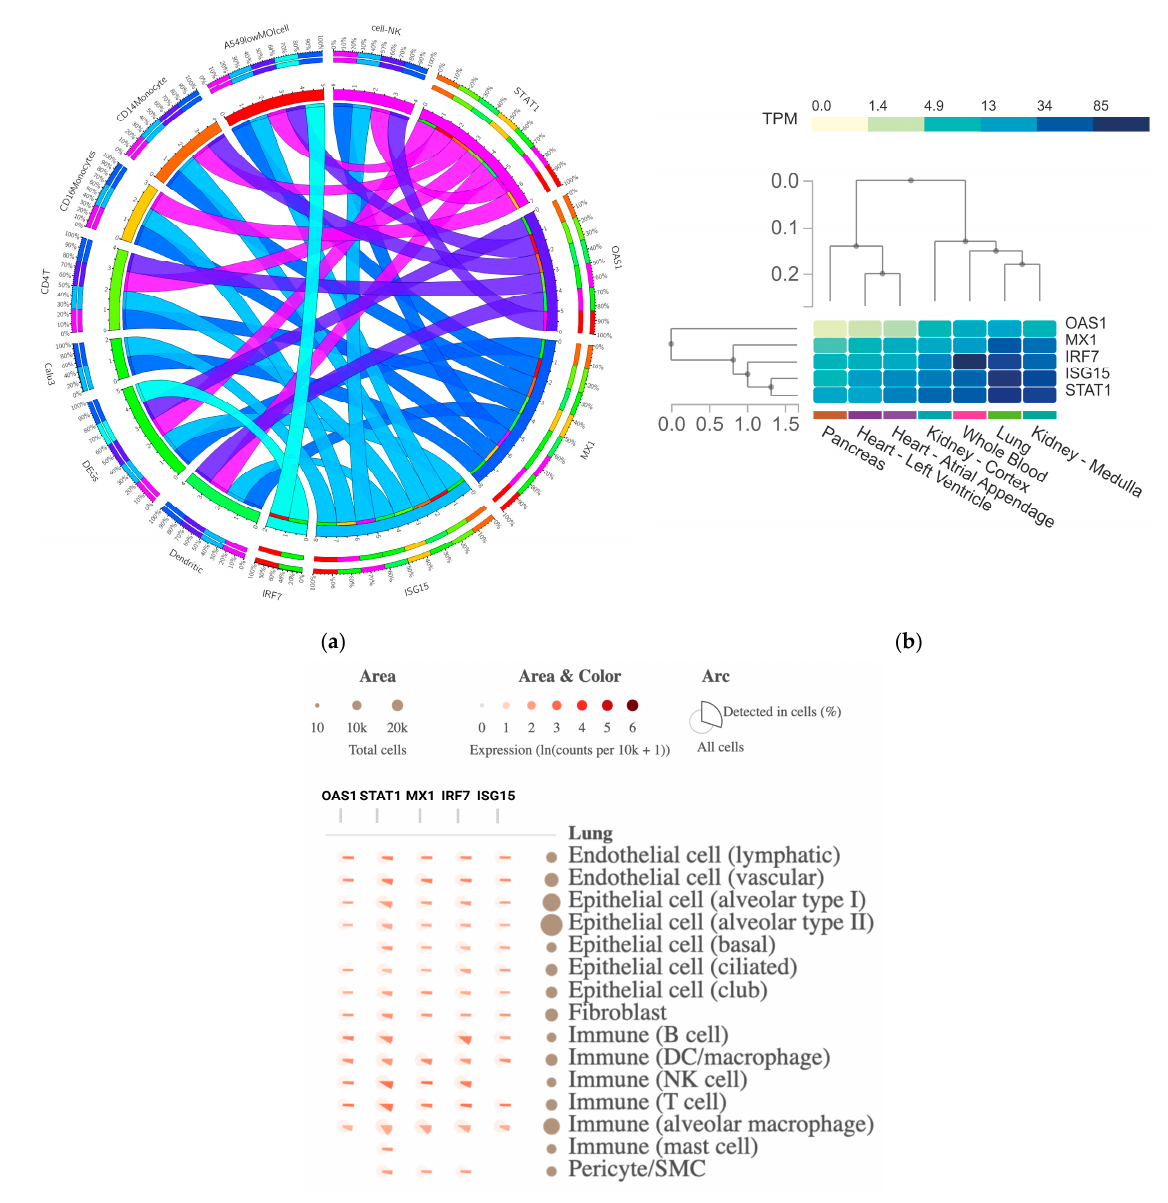
Figure 9. In-silico validation of gene expression of hub genes across other databases. ( a ) Circa plot depicts the number of shared DEGS across the 8 types of COVID-19 datasets under study. In the hemisphere, the 5 hub DEGs are represented by an arc: OAS1 , STAT1 , CXCL10 , ISG15 and MX1 . The inner arcs represent the distribution of the hub genes in each COVID-19 dataset, while the outside arcs represent the intersection of both hemispheres on a scale of 0–100%. Data was obtained from the Coronascape database including dendritic cells, Calu3, CD4T, CD16 monocytes, CD14 monocytes, NK cells and A549lowMOI cell samples (https://metascape.org/COVID/, accessed on 14 September 2022). ( b ) Heatmap comparison of hub ‘ healthy tissue expression and ( c ) lung single-cell